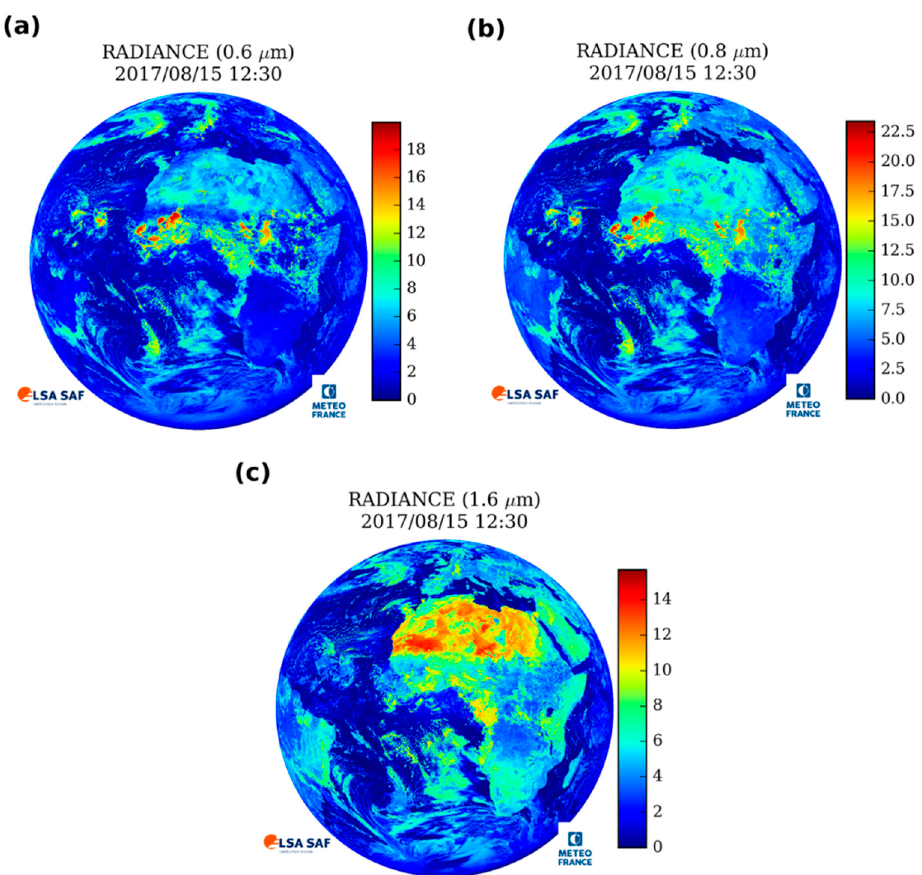
Figure 2. Example of Meteosat Second Generation (MSG)-Spinning Enhanced Visible and Infrared Imager (SEVIRI) radiances (mW m − 2 sr − 1 (cm − 1 ) − 1 ) at the TOA level on the 15 August 2017 at 12:30 UTC for channels centered at ( a ) 0.6 µ m, ( b ) 0.8 µ m, and ( c ) 1.6 µ m.